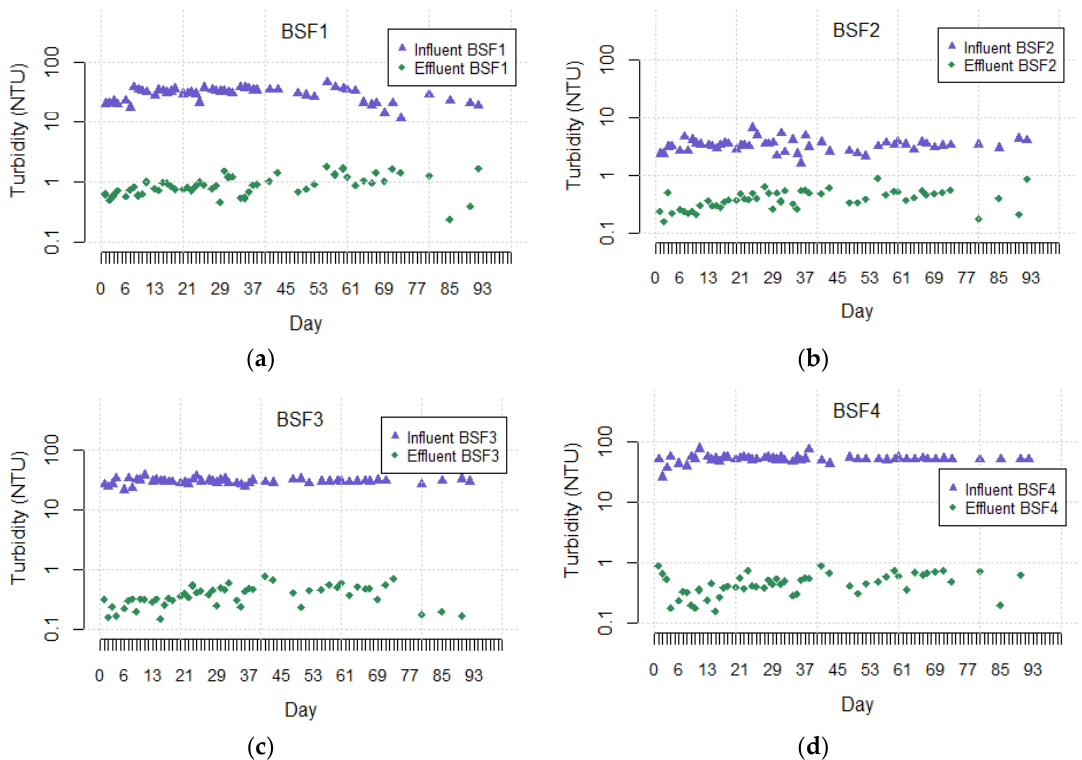
Figure 3. Influent and effluent turbidity over the course of the experiment: ( a ) BSF1, ( b ) BSF2, ( c ) BSF3 and ( d ) BSF4.